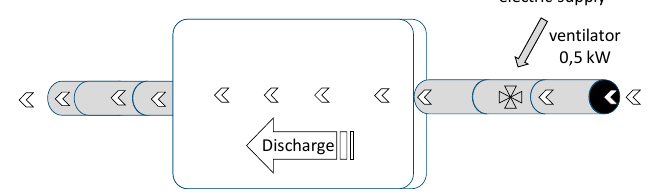
Figure 6. Discharging the PCM accumulator using a stream of air.